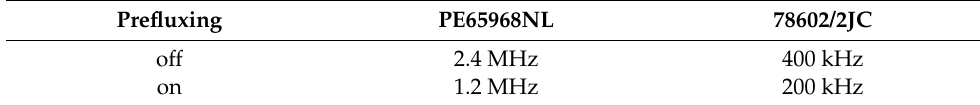
Table 3. Lowest limit improvement achievable with prefluxing